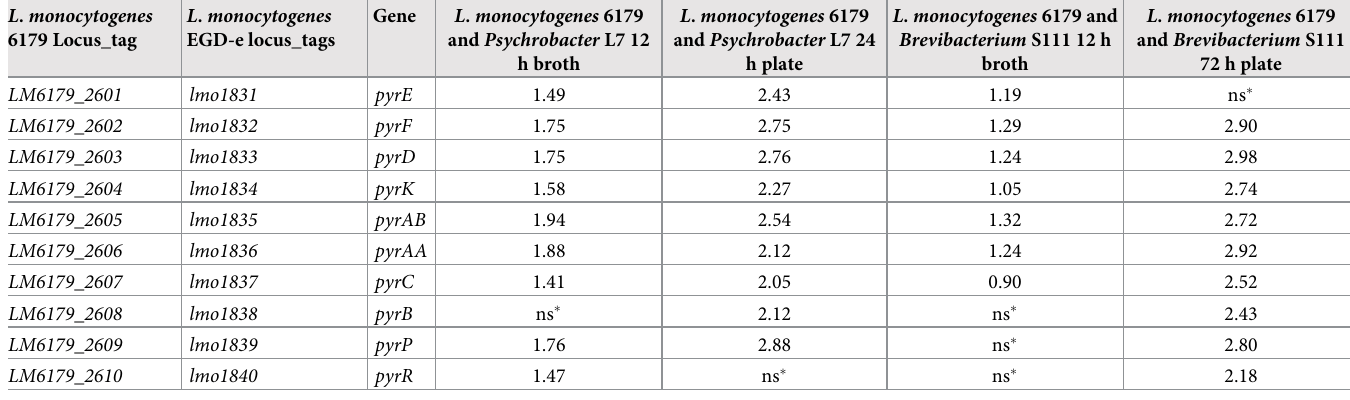
Table 6. Differential expression of the pyrimidine biosynthesis and salvage locus during co-cultivation of L . monocytogenes 6179 and cheese rind bacteria. L . monocytogenes 6179